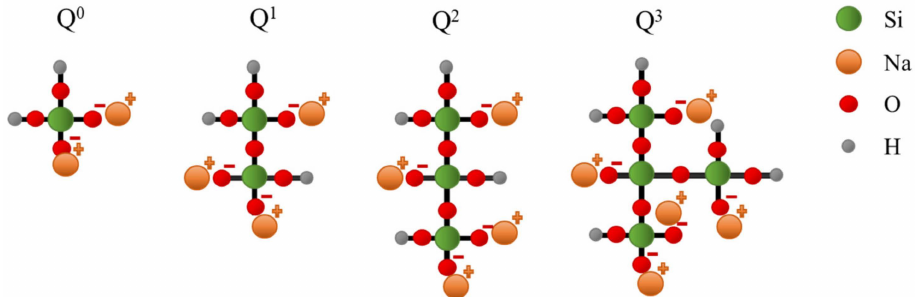
Figure 10. A unit of Q 0 , Q 1 , Q 2 , and Q 3 silicate